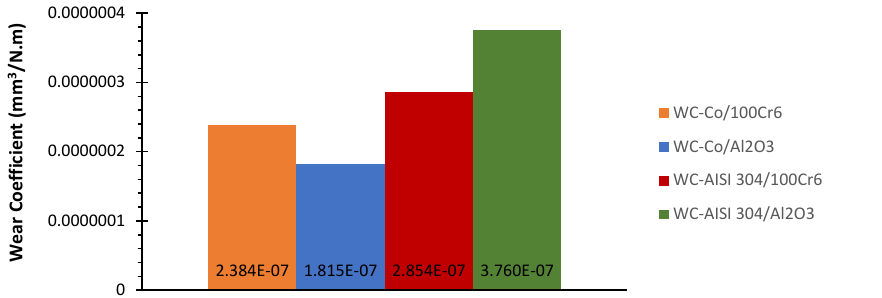
Figure 11. Disc wear coefficients for the systems: WC-Co/100Cr6, WC-Co/Al 2 O 3 , WC-AISI 304/100Cr6 and WC-AISI 304/Al 2 O 3 . In a first analysis of the discs wear coefficients, it appears that they have the same order of magnitude. The lowest wear coefficient belongs to system WC-Co/Al 2 O 3 with the value of 1.815 × 10 −7 mm 3 /N.m. Following, are the wear coefficients of systems WC- Co/100Cr6 and WC-AISI 304/100Cr6, which are 31 and 57% higher, respectively. The high- est wear coefficient corresponds to the system WC-AISI 304/Al 2 O 3 , with 3.760 × 10 −7